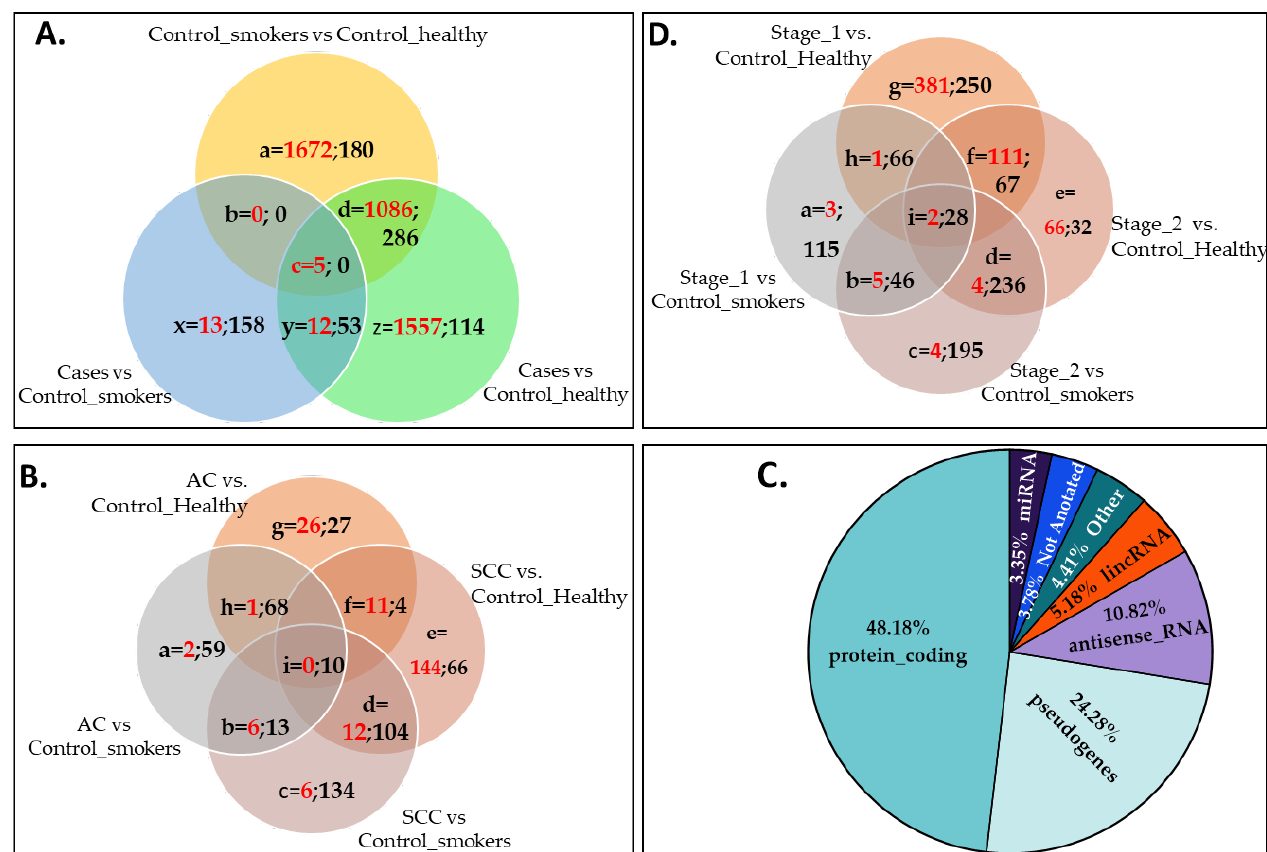
Figure 1. Distribution of NSCLC-associated cfRNA. A : cfRNA in plasma samples from cases. B : cfRNA in subtypes AC and SCC. C : Distribution of NSCLC-associated cfRNA within functional categories. The most common pseudogene subcategories were processed_pseudogenes (17.99%), unprocessed_pseudogenes (2.89%), and transcribed_unprocessed_pseudogenes (1.82%), and other subtypes were present <1%. The “Other” category included the following subcategories at less than 1% abundance: IG_V_genes, snoRNA, processed_transcripts, TR_V_genes, TR_J_genes, sense_intronic, misc_RNA, scaRNA, sense_overlapping, IG_C_genes, TR_C_genes, 3prime_overlapping_ncRNA, IG_J_genes, TEC, and TR_D_genes. D : cfRNA within categories based on NSCLC stage. The numbers presented in red and black color fonts in Figure 1A – 1C represent up- and down-regulated genes, respectively.